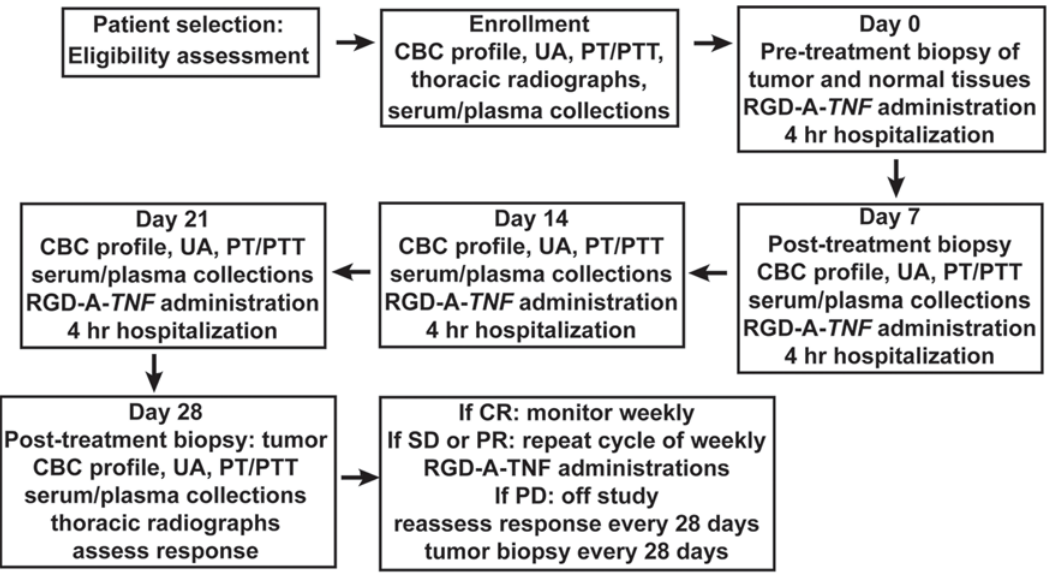
Figure 3. Schema representing the schedule for the multi-dose phase of RGD-A- TNF evaluation in dogs with spontaneous cancers. This study was designed as an open label, multiple fixed-dose trial (i) to establish feasibility and (ii) to identify chronic and/or cumulative toxicity of repetitively administered RGD-A- TNF . Dogs received weekly doses (5 6 10 12 TU intravenously) of RGD-A- TNF . Anticancer activity of this agent was evaluated using RECIST criteria. The treatment received population included dogs that received at least four weekly doses (i.e., one cycle 1). This population consisted of 14 dogs. Dogs were permitted to receive additional therapy in subsequent cycles if there was evidence of either stable disease or tumor response. Tumor measurements were recorded every two weeks with full restaging every 28 days.